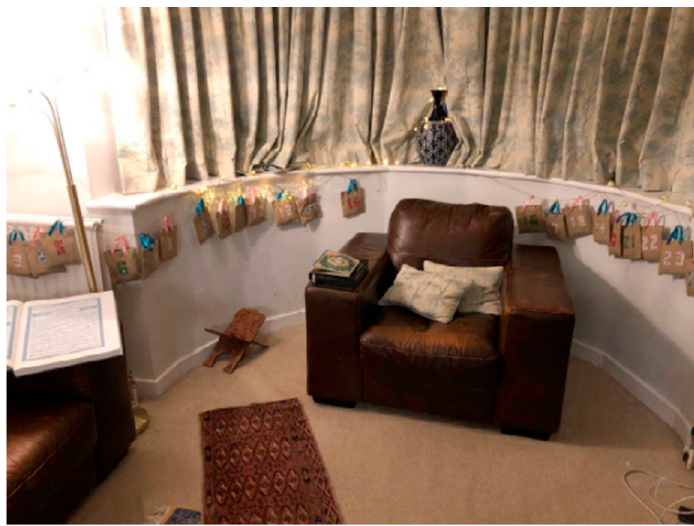
Figure 2. Jennifer’s Ramadan prayer space (Jennifer, Diary Image, Day 2).